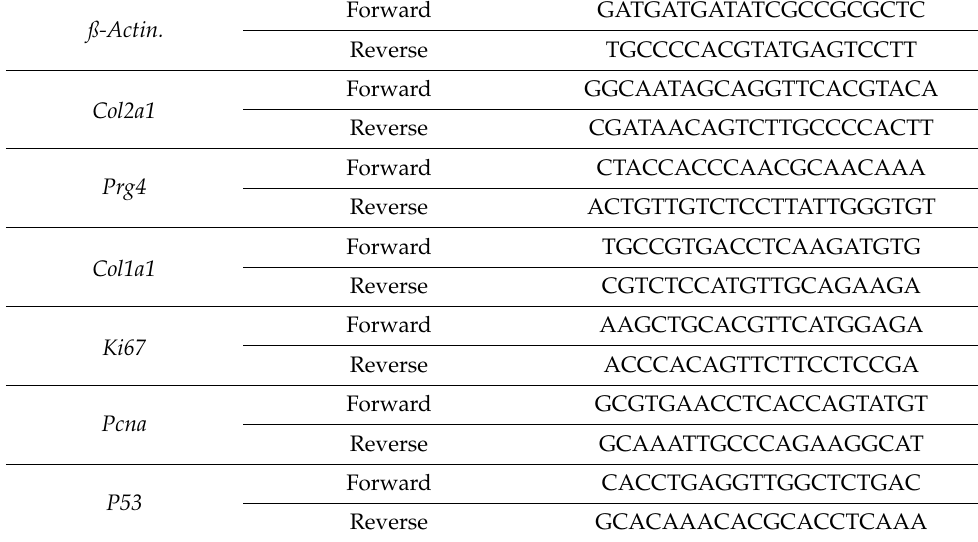
Table 1. Primers used for RT-qPCR.